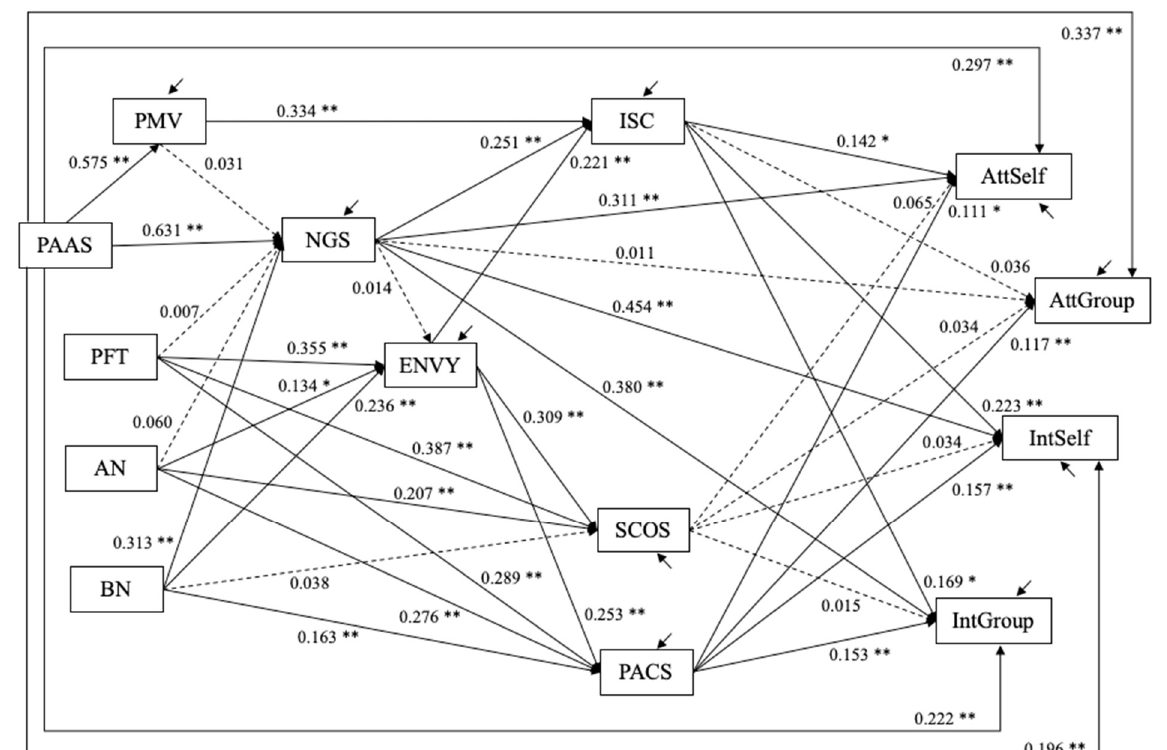
Figure 8. Study 3: Estimated structural equation model (Model I, N = 557).